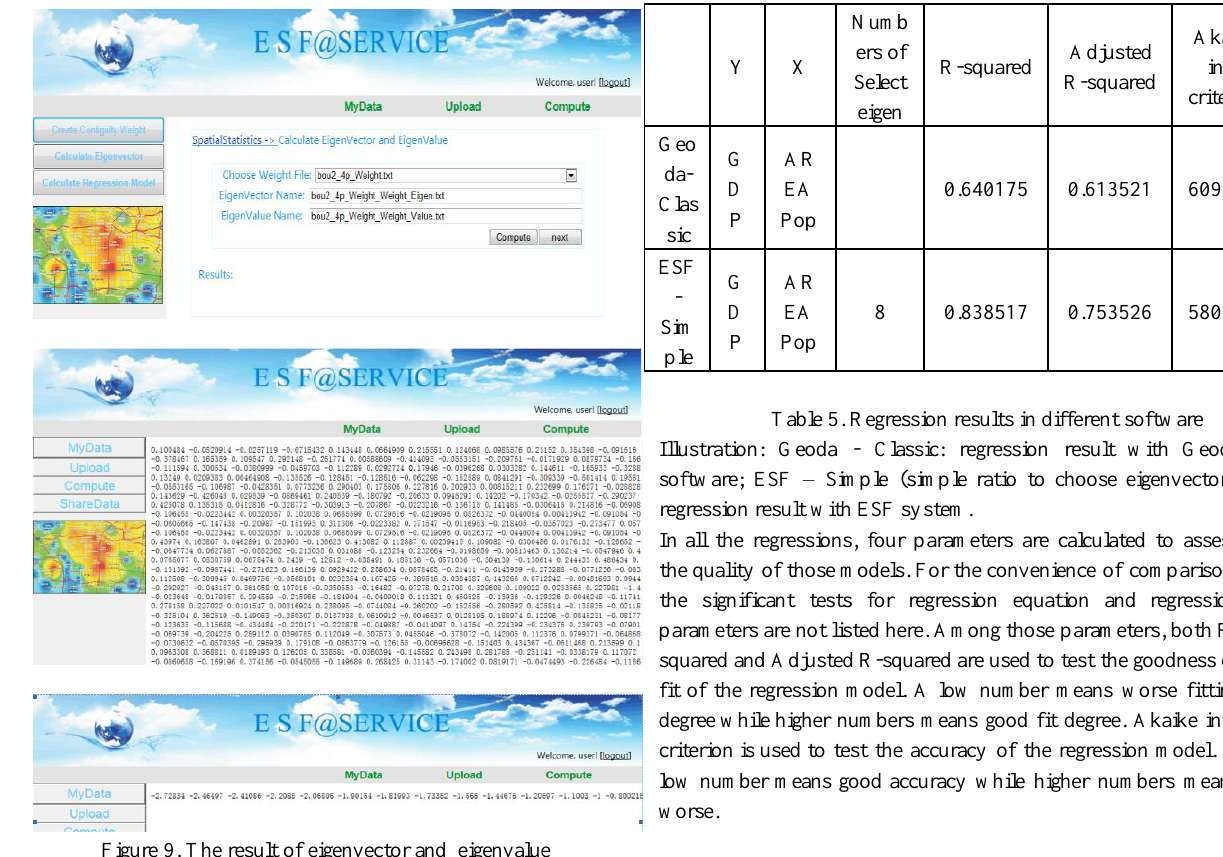
Table 5. Regression results in different